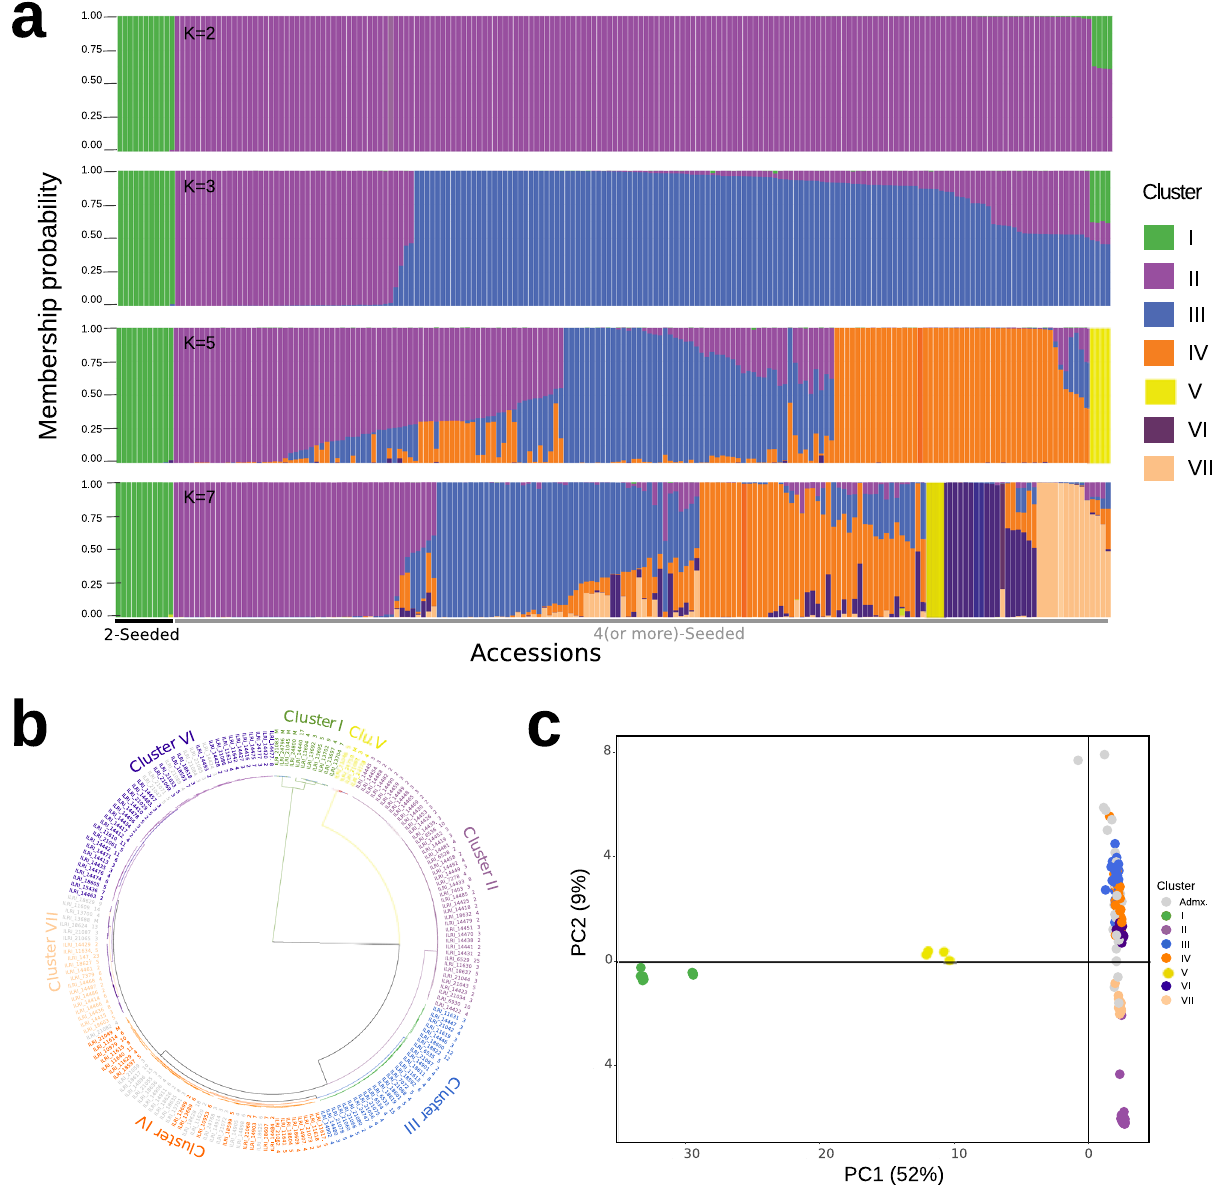
Fig.5|Populationgeneticanalysisoflablab.a Barplotsbased ontheadmixture modelinSTRUCTUREformultiple K (Membershipofindividualaccessionstoeach subgroup is given in Supplementary Table 6). b Clusters detected by hierarchical